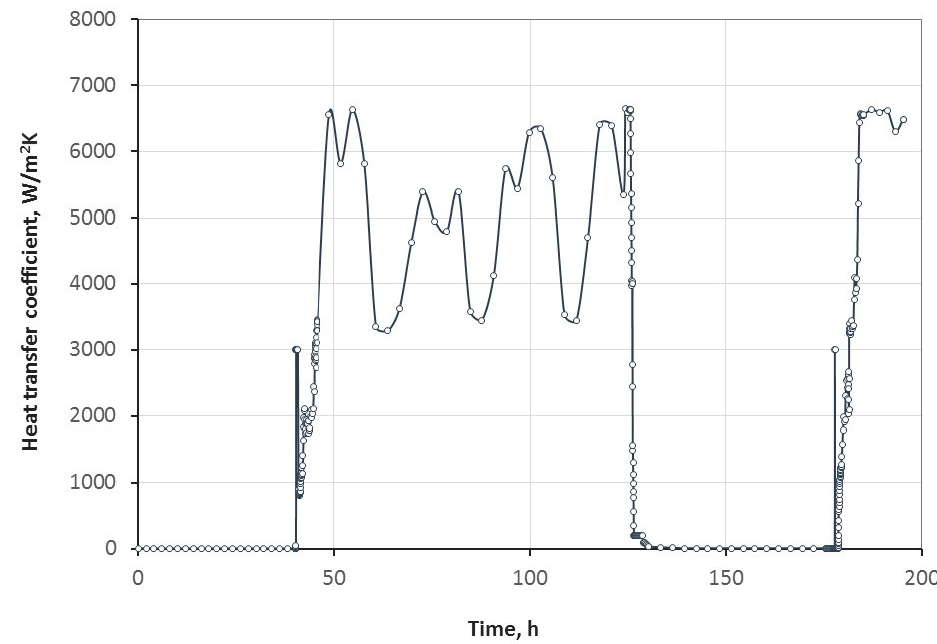
Figure 12. Modified graphs of changes in the heat transfer coefficient as a function of temperature; increased coefficient α at the initial stage of the startups is considered, which equals 3000 W/m 2 K.